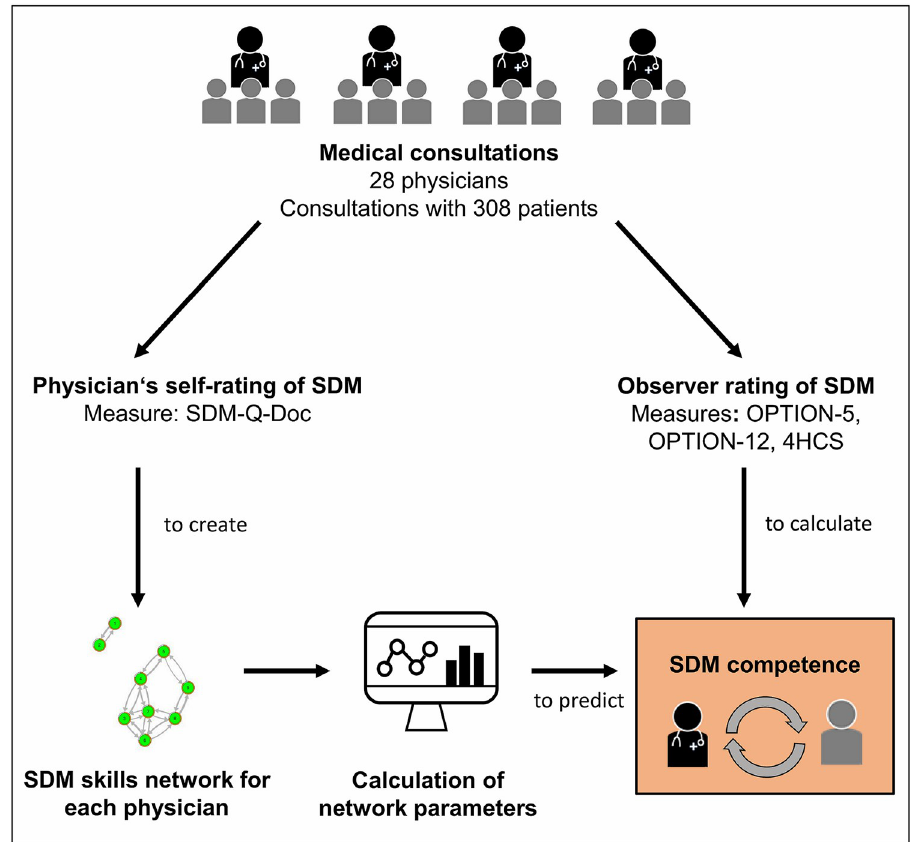
Fig 1. Overview of the research design, measures and analysis. SDM, Shared Decision Making; SDM-Q-Doc, Shared Decision Making Questionnaire—physician version; 4HCS, Invest in the End subscale of the Four Habits Coding